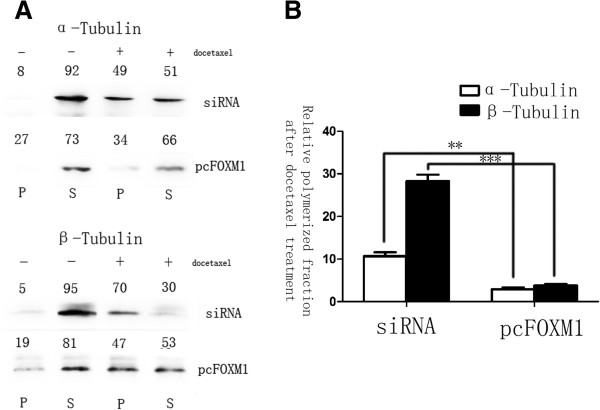
FOXM1 alters the microtubule dynamics in preventing docetaxel induced apoptosis. Polymerized and soluble tubulin fractions from docetaxel untreated and treated FOXM1-siRNA and pcDNA3, 1-FOXM1 transfected cell lines were generated by centrifugation. Western blot was used to assay α-tubulin and β-tubulin ratios in polymerized and soluble fractions. (A) Relative percentages are shown above western blot. (B) The soluble to polymerized microtubule fractions after docetaxel treatment were significantly inhibited in FOXM1 overexpressed group, analyzed by t test both for α-tubulin and β-tubulin. **, P ≤ 0.01; ***, P ≤ 0.001 significant.